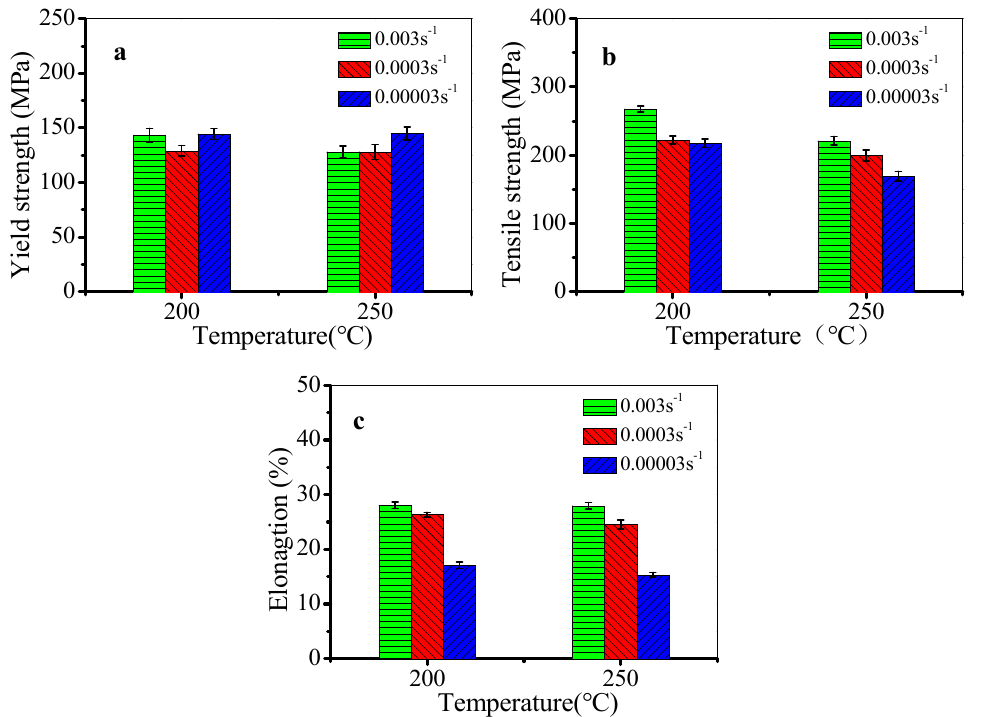
Figure 12. Mechanical properties of the stretched alloy at 200 °C and 250 °C: ( a ) yield strength; ( b ) tensile strength; ( c ) elongation.